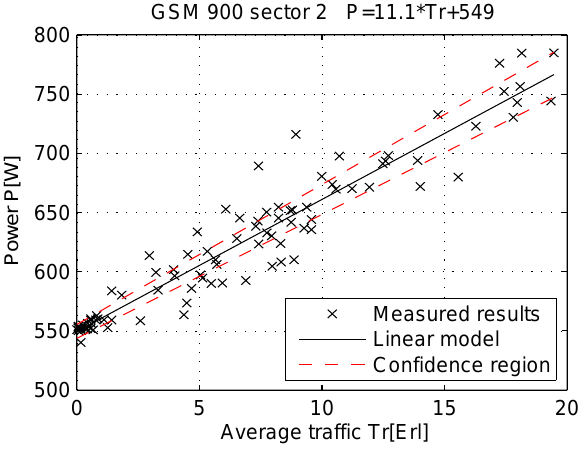
Figure 26. Power consumption model for GSM 900 sector 2 BS rack (total measuring